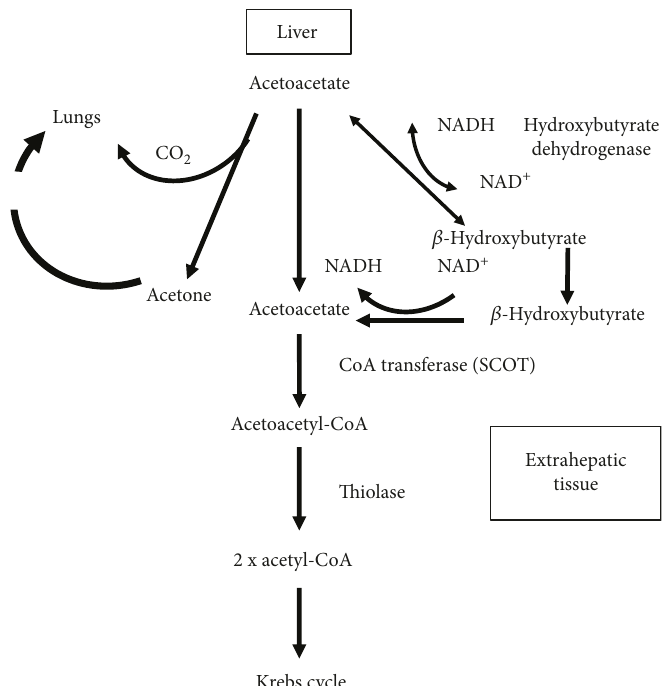
Figure 2: Tissue utilization of ketone